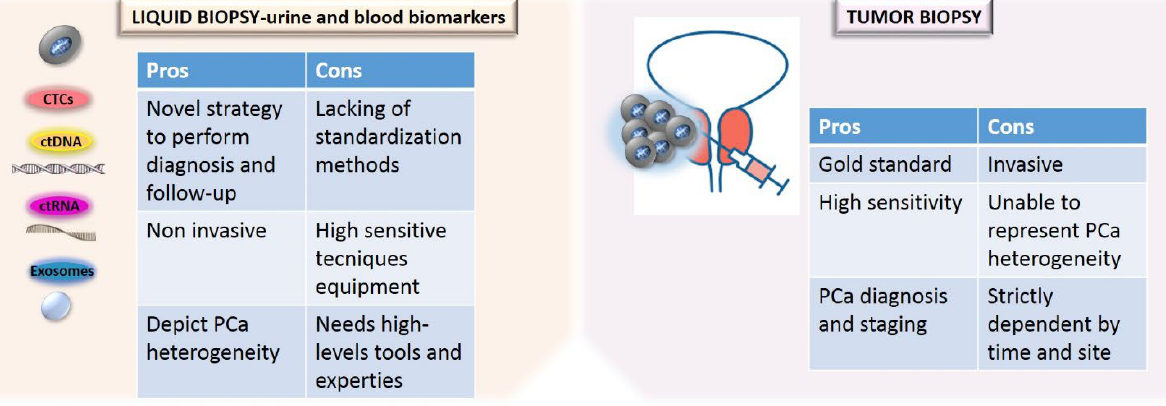
Figure 2. Comparison of the advantages and limitations of tissue versus liquid biopsy.